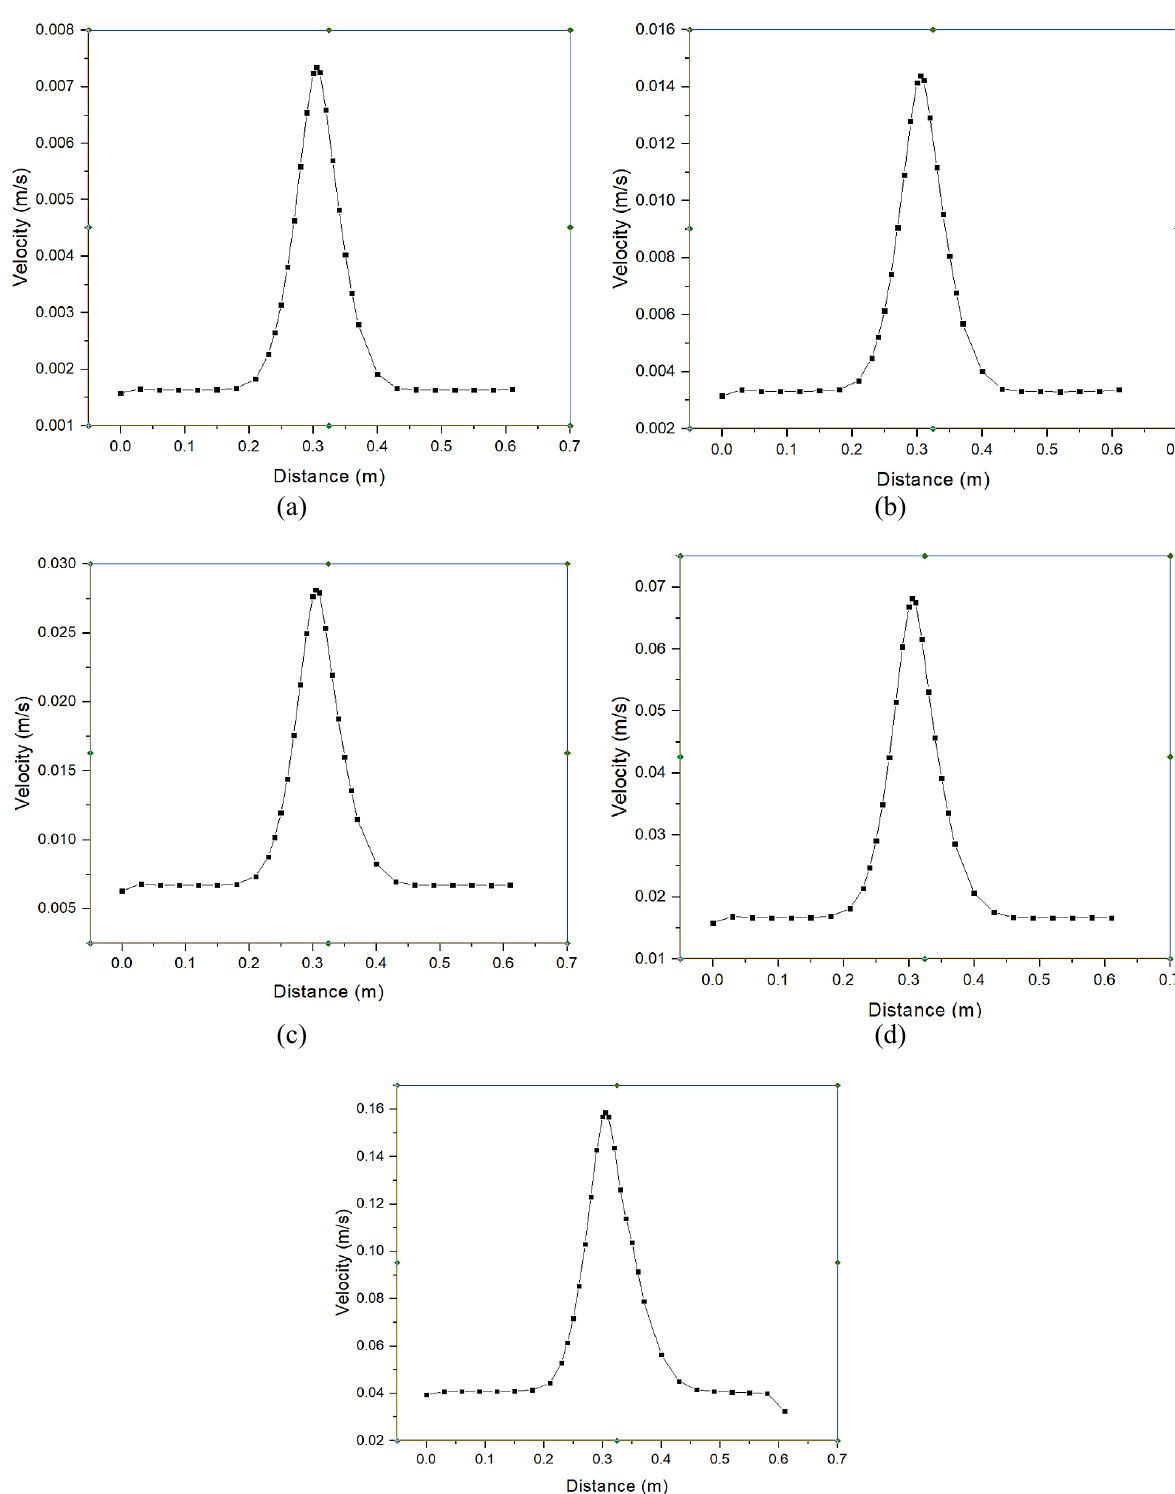
Fig. 5. Variation of velocity with Reynold Number (a) Re=100 (b) Re=200 (c) Re=400 (d) Re=1000 (e) Re=